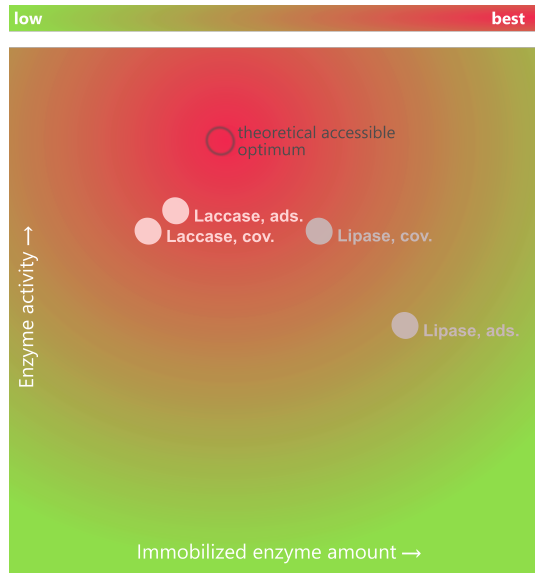
Figure 5. Classification of used immobilization strategies for laccase and lipase compared to a theoretically-accessible optimum of enzyme immobilization. Red shading represents better results, while green shading otherwise symbolizes lower immobilization rates and/or lower enzyme activity. The figure compares the respective optimal conditions of enzyme immobilization for adsorptive (ads.) immobilization without SDS treatment and for covalent (cov.) immobilization results after washing with SDS solution. Activity values were compared to the free enzymes as given in Table